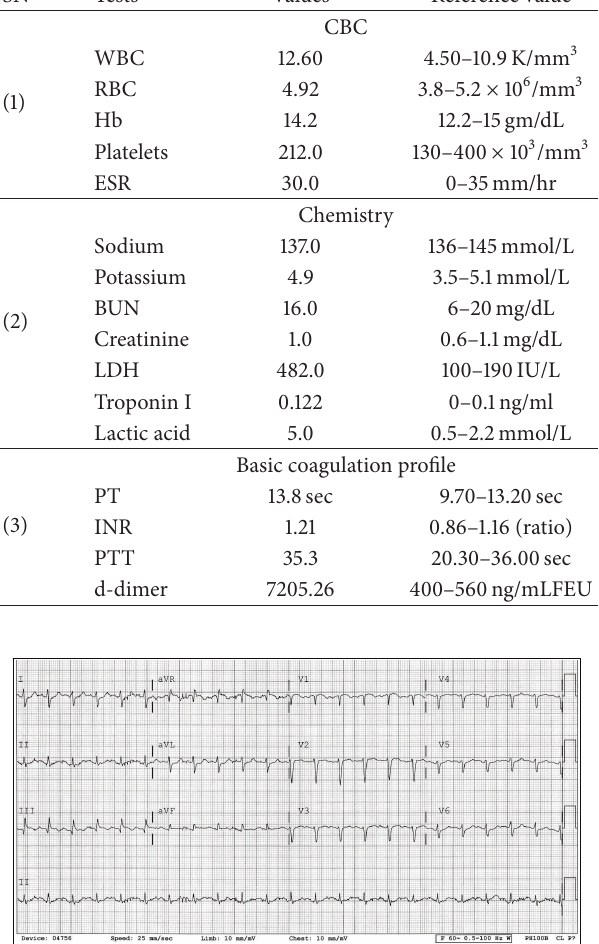
Figure 1: 12-lead EKG showing right ventricular strain